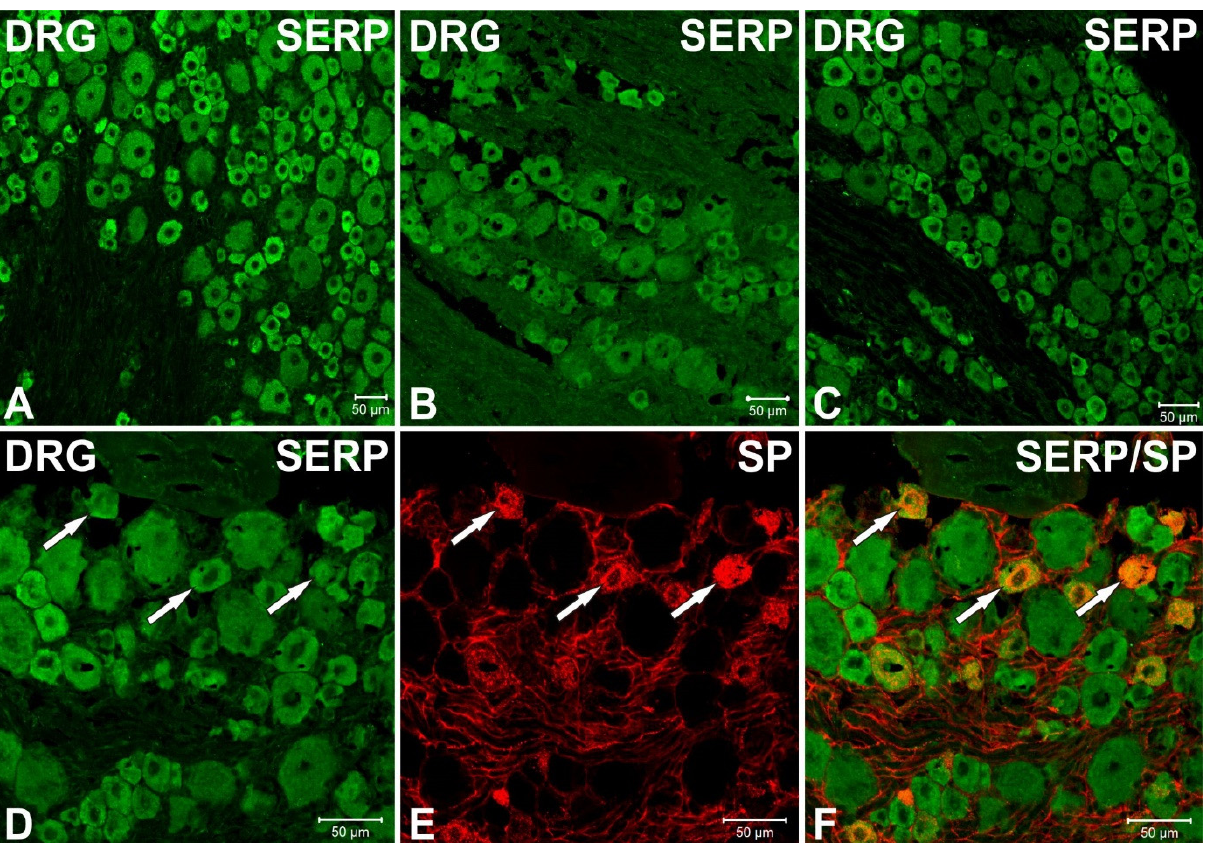
Figure 3. Serpinin-LI in rat thoracic DRG showing double-immunofluorescence of serpinin/SP. Many serpinin immuno-positive cells were observed in these ganglia (green), the cells featured a diameter of 20–30 µm and were arranged mainly in clusters ( A – C ). Furthermore, double-immunofluorescent studies of serpinin (( D ), green) with SP-IR (( E ), red) revealed colocalization (indicated by arrows in ( D , E ), arrows in the superimposed image ( F ), orange) but most serpinin positive cells were devoid of SP-IR. Scale bars represent 50 µm.